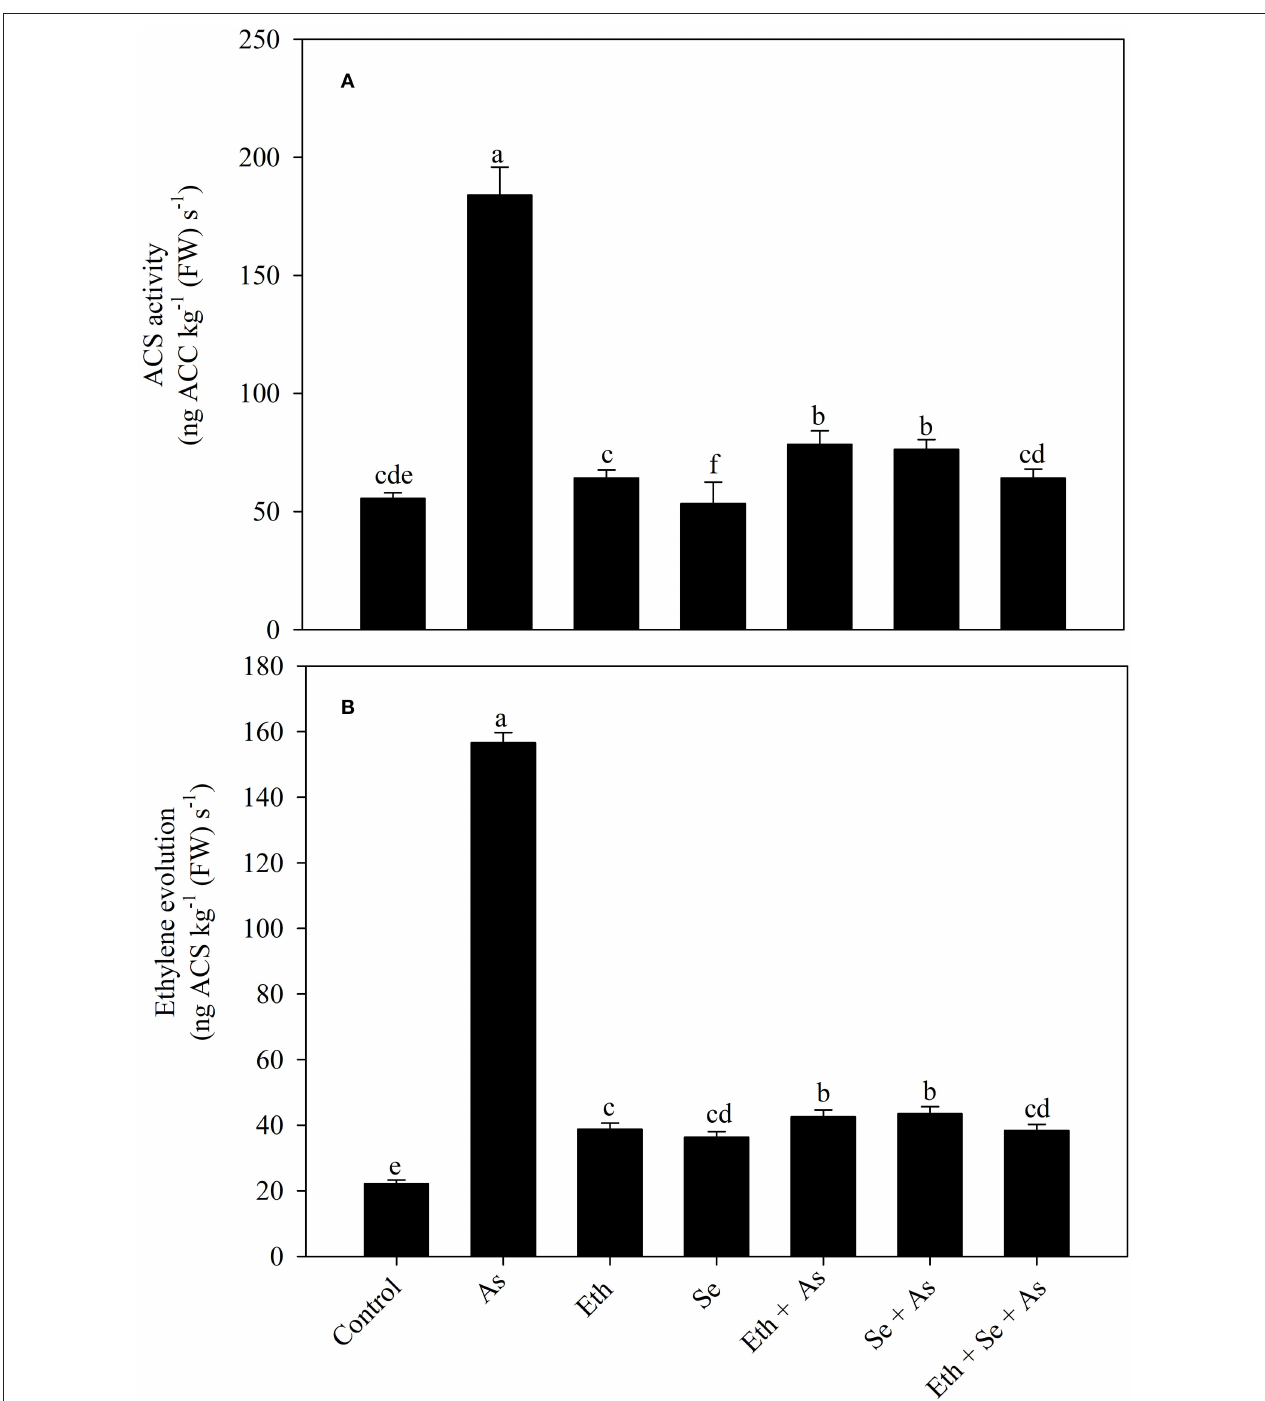
FIGURE 3 | Activity of ACS (A) and ethylene evolution (B) in mustard ( B. juncea L.) leaves grown with 200 µ l L − 1 Eth and/or 2-mg Se kg − 1 soil in the presence or absence of 24-mg As kg − 1 soil at 30 DAS. Data are presented as treatment mean ± SE ( n = 4). Data followed by the same letter are not significantly different by LSD test at p < 0.05. ACS, 1-aminocyclopropane carboxylic acid; As, arsenic; Eth, ethephon; Se, selenium.